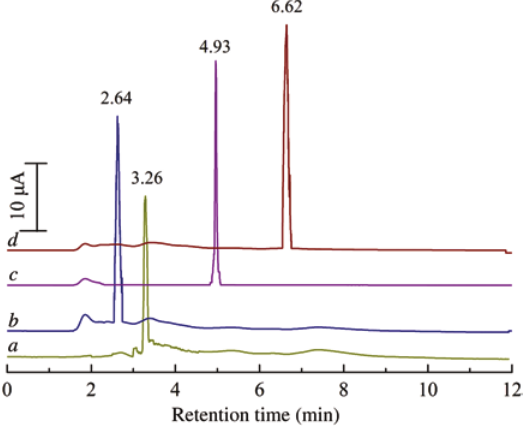
Figure 7: The HPLC profiles of imidazolidine-2,4-dione (curve a ), 1,3-dimethylol-5,5-dimethylimidazolidine-2,4-dione (curve b ), 5-(4-hydroxyphenyl)imidazolidine-2,4-dione (curve c ), and 5,5-diphenylimidazolidine-2,4-dione (curve d ) standards at a concentration of 0.55 mg/ml in a water/acetonitrile/phosphoric acid (90:10:0.01, V/V ) mixture system. UV-Vis detector was set at 280 nm; the injection volume and the elution rate were 10 μ l and 1.0